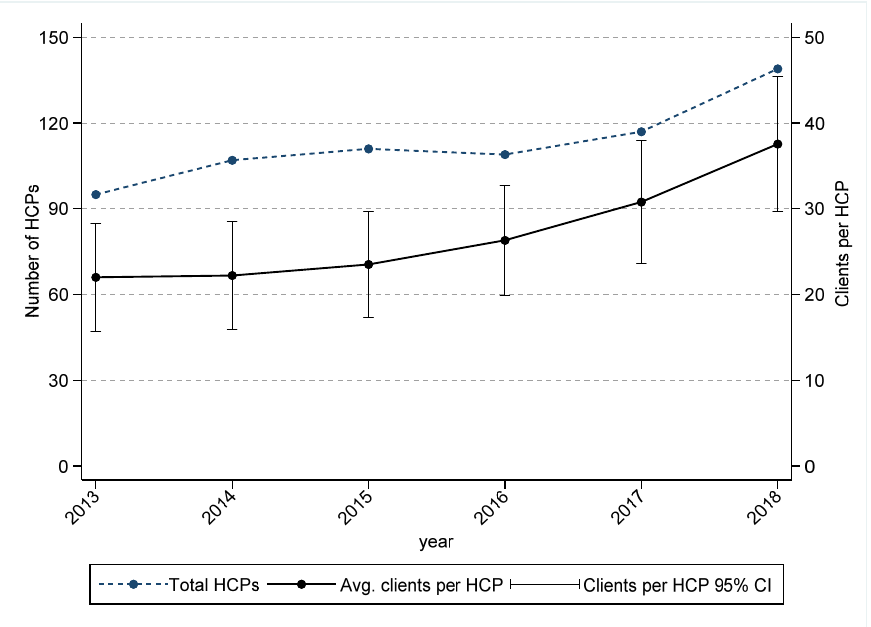
Figure 4. Trends in workforce capacity and patients per health care practitioner, Western Sydney